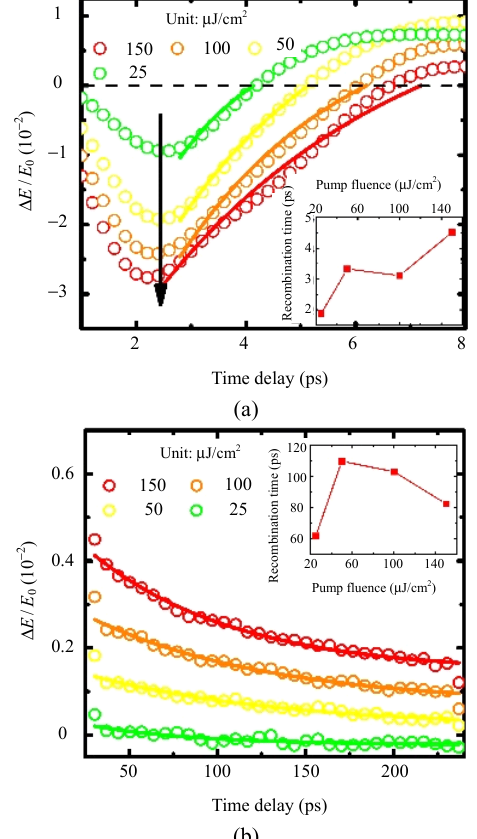
Fig. 5 Excitation dynamics of the 8 QL Bi 2 Se 3 sample with respect to the pump-probe delay dominated by: (a) bulk state (within ~5 ps) and (b) TSS, respectively. The empty circles are experimental results by using the OPTP measurements for various pump fluences. The solid lines are the fitting results of the recombination processes. The insets describe the recombination time as a function of pump